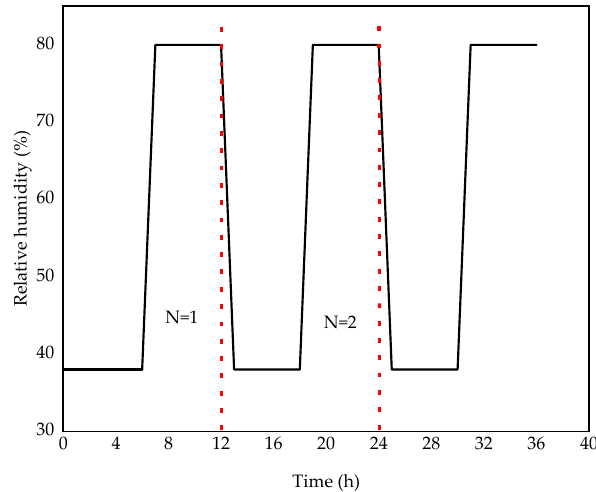
Figure 1. Constant temperature dry and wet cycle sequence .